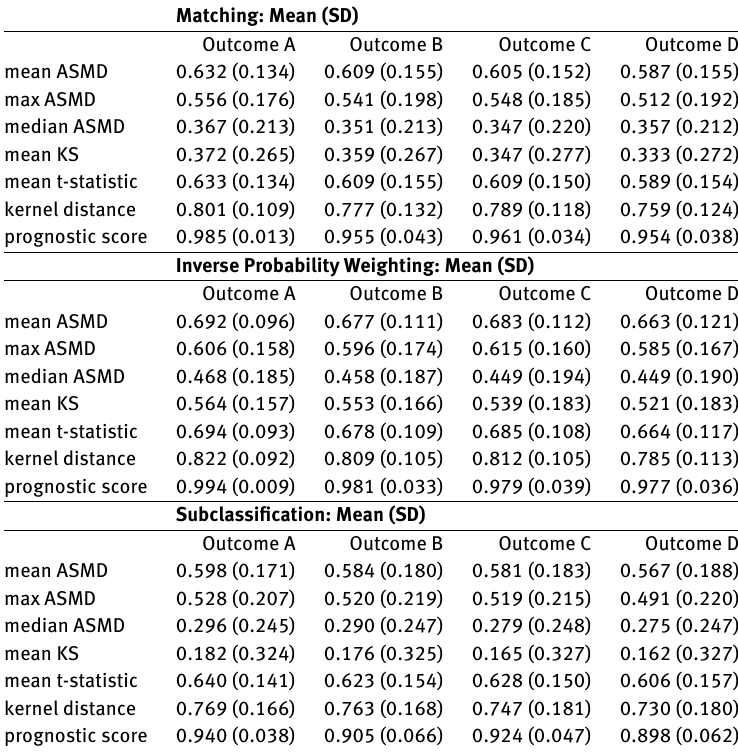
Table 2: Mean and standard deviation of the Pearson correlation